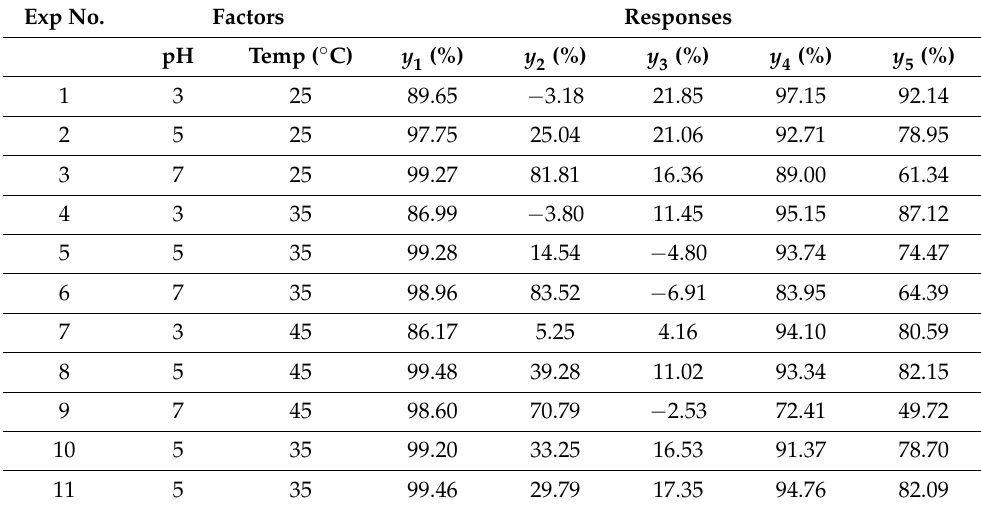
Table 3. Experimental matrix for factor studies and retention percentages by NF99HF. Exp No. Factors